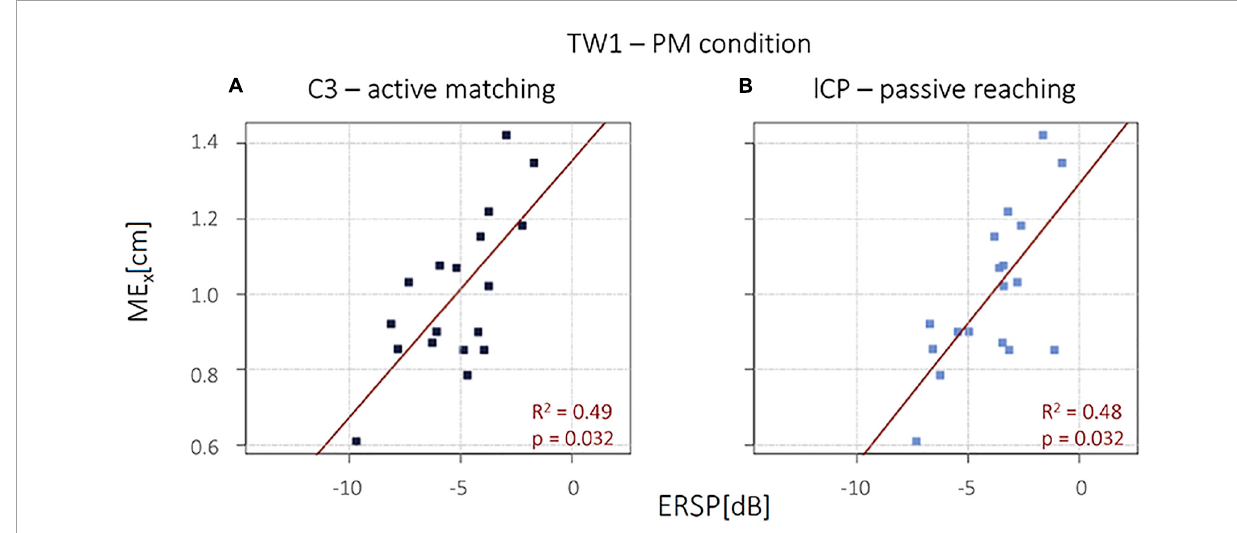
FIGURE3 (A) Event-related spectral perturbation (ERSP) mean values in C3 during active movement. (B) ERSP mean values in lCP during passive movement.